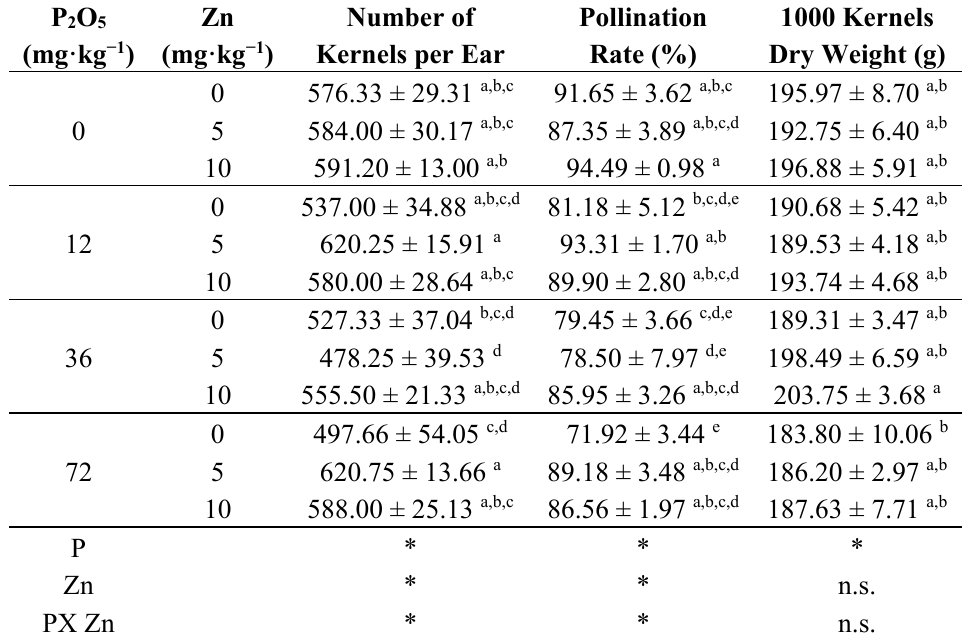
Data are the means ± standard error ( n = 4). For each measured parameter, means without common letter